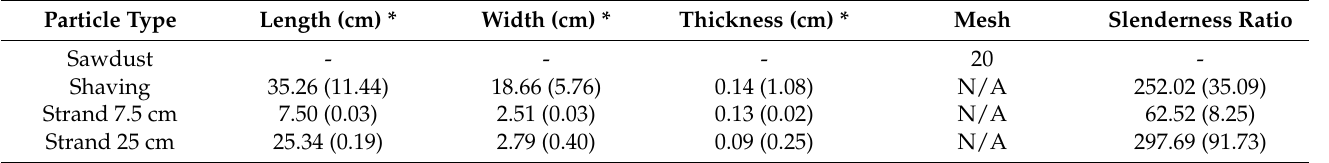
Table 1. The particle size of Styrax sumatrana wood and Gigantochloa pruriens .